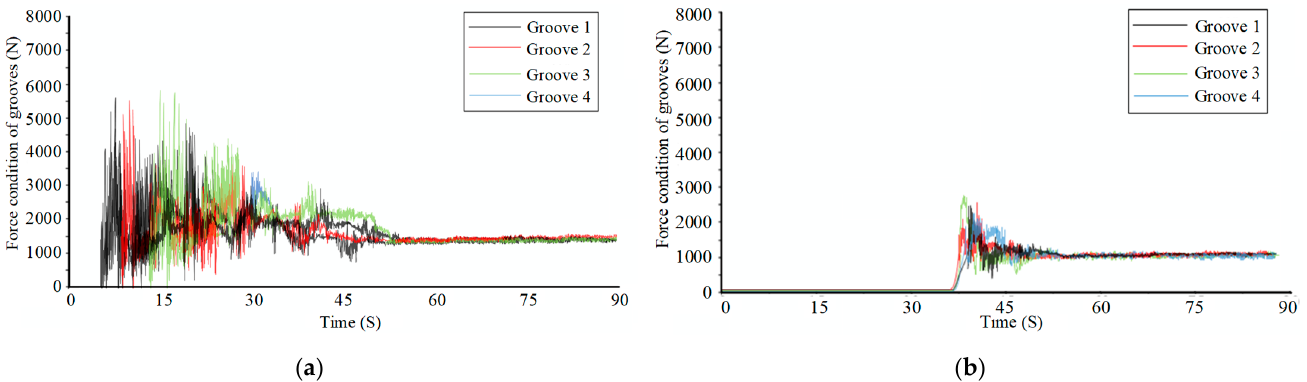
Figure 14. Contact force comparison of cooperative docking capture strategy: ( a ) Group ① ; ( b ) Group ② . Table 4. The initial docking conditions of the synchronous docking capture.